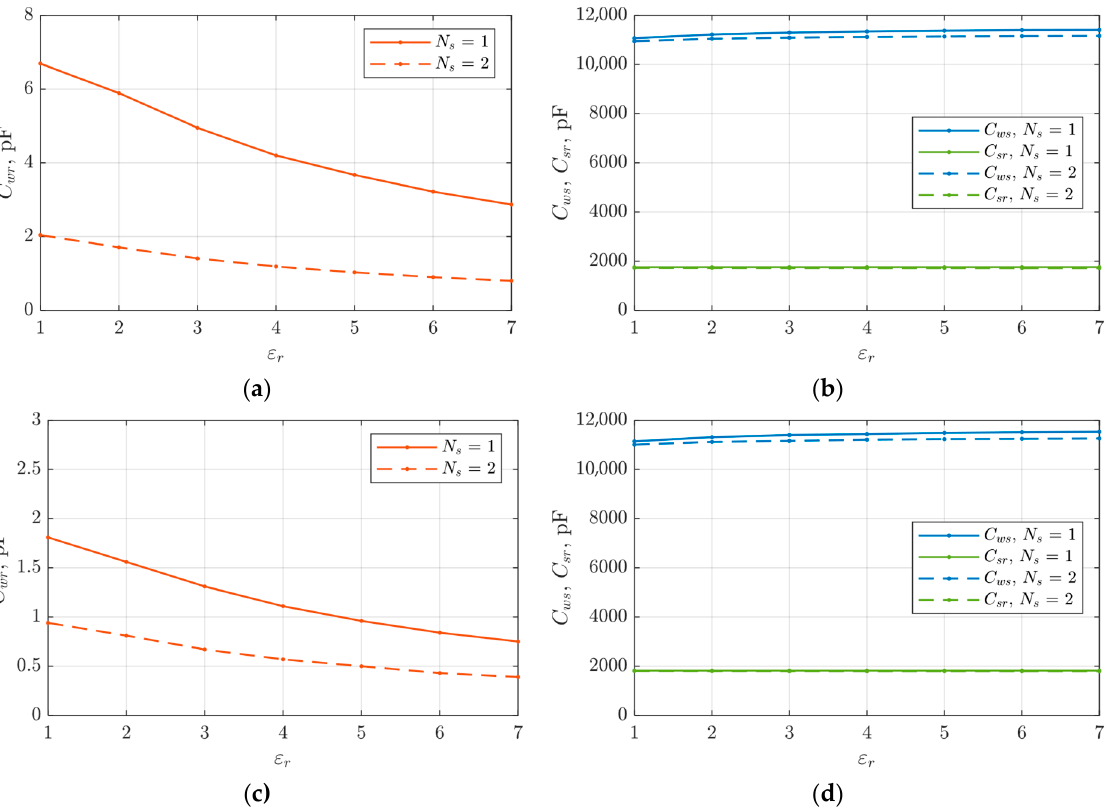
Figure 18. Characteristics of capacitance changes: ( a ) C wr ( B s0 ′ = 2.8 mm), ( b ) C ws and C sr ( B s0 ′ = 2.8 mm), ( c ) C wr ( B s0 ′ = 2 mm), ( d ) C ws and C sr ( B s0 ′ = 2 mm) depending on the width of the oblique openings of the slots and the electric permeability of the wedges.